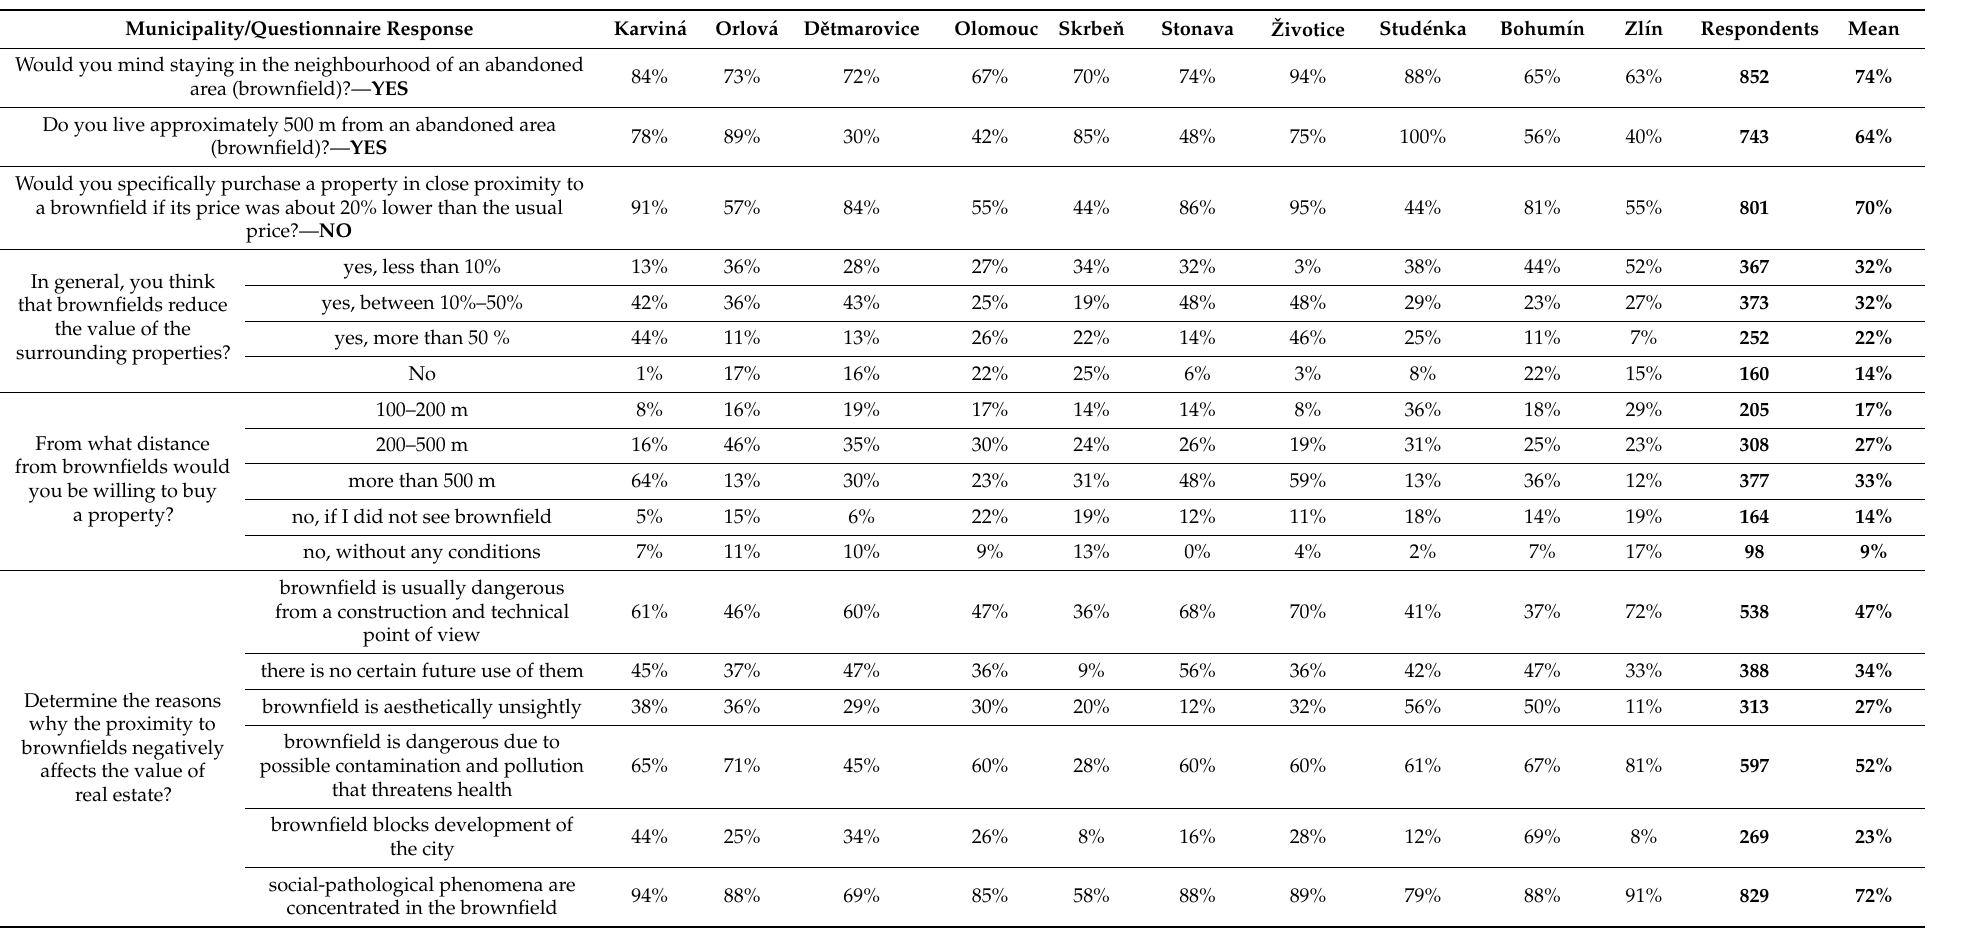
Table A1. Data tables for selected